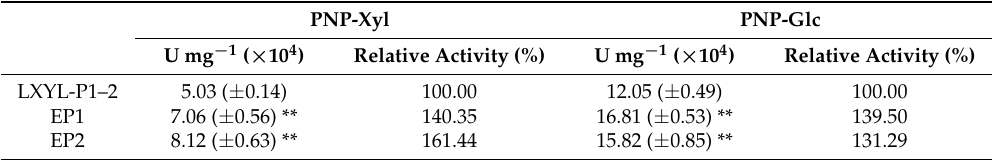
Table 2. Specific activities of EP1 and EP2 against PNP-Xyl and PNP-Glc.